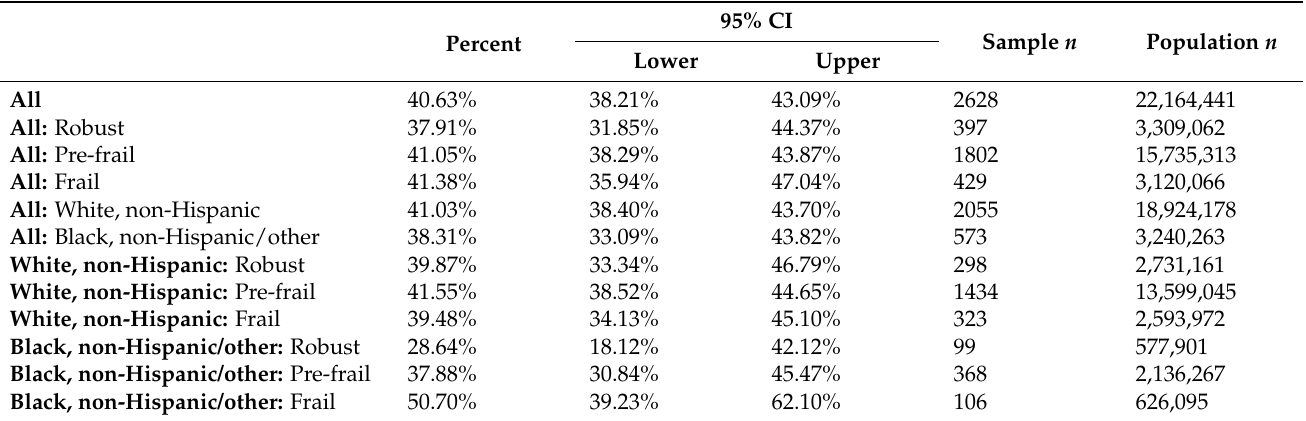
Table 2. Percentage of putting off care by frailty and race/ethnicity. 95% CI Sample n Population n Percent Lower Upper